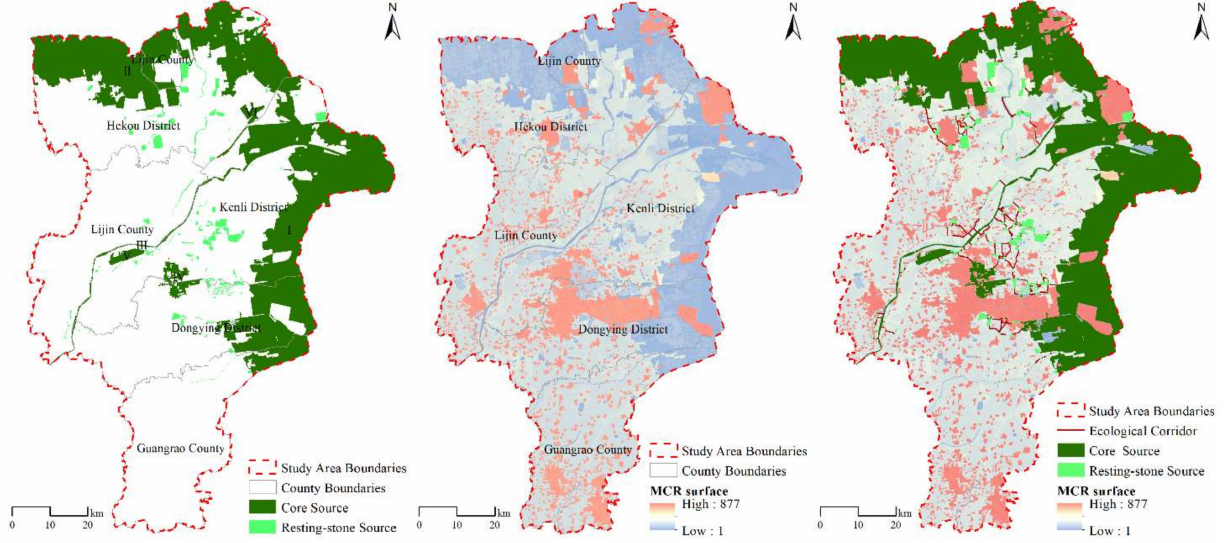
Figure 6. Distribution of ecological sources ( left ), ecological resistance surfaces ( middle ), and ecolog- ical corridors ( right ) in Dongying